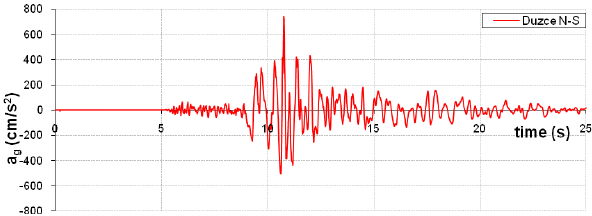
Figure 7: Acceleration record of the 1999 Düzce earthquake N-S component Fig. 7. Acceleration record of the 1999 D¨uzce earthquake N-S The peak ground acceleration (PGA) measured on site was 0.8 g and 0.5 g. Columbia and Paris Universities declared that they measured a PGA of about 1.0-1.1 g based on data obtained from their stations located in Karadere on the other side of fault. This value is much more than the design value as shown in Figure 8 (Yılmaz and Türer, 2002).